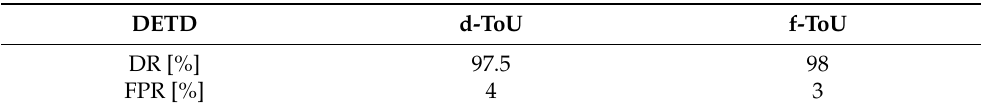
Table 3. Average theft detection performance of DETD when using the d-ToU and f-ToU window- based theft cases for an average of 1000 consumers. Figure 3. Schematic diagram of the DETD algorithm.